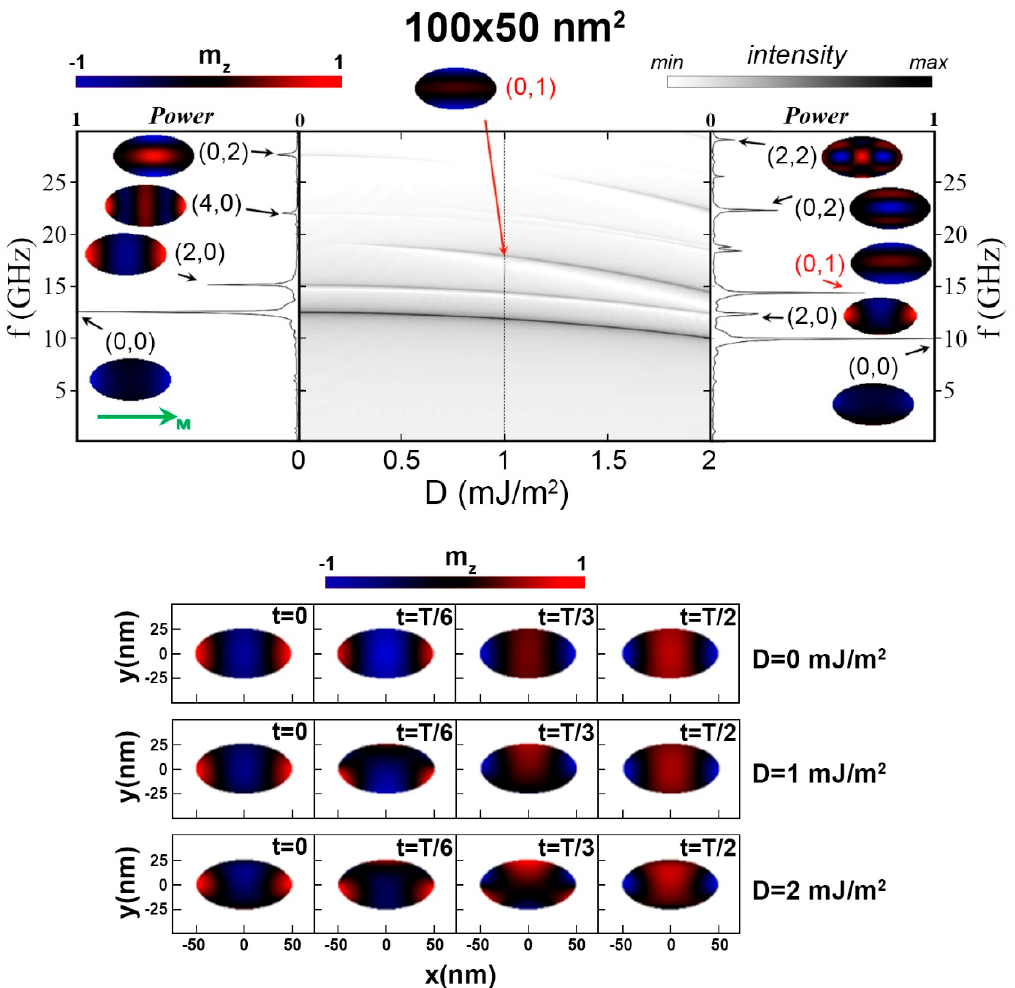
Figure 3. Top central panel: dependence of the frequencies of the spin wave eigenmodes on the DMI constant D for the elliptical dot of lateral dimensions 100 × 50 nm 2 . On the left- and right-hand sides, the intensity spectra corresponding to D = 0 and 2 mJ/m 2 are reported, respectively, together with the color insets that represent the spatial profile of the dynamical magnetization, expressed as the product of the modulus of the dynamical magnetization by the sign of its phase. Bottom panel: spatial profile of the mode (2,0) plotted at different times during the period T, for three different values of D . The animations with the movies of the dynamics of all the modes for several values of D are available in the supplemental material.